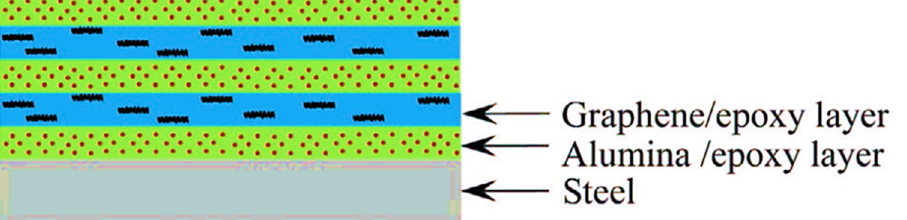
Figure 4. Schematic diagram of mechanism of action across five layers of coating [70]. Reproduced with permission from Wiley.